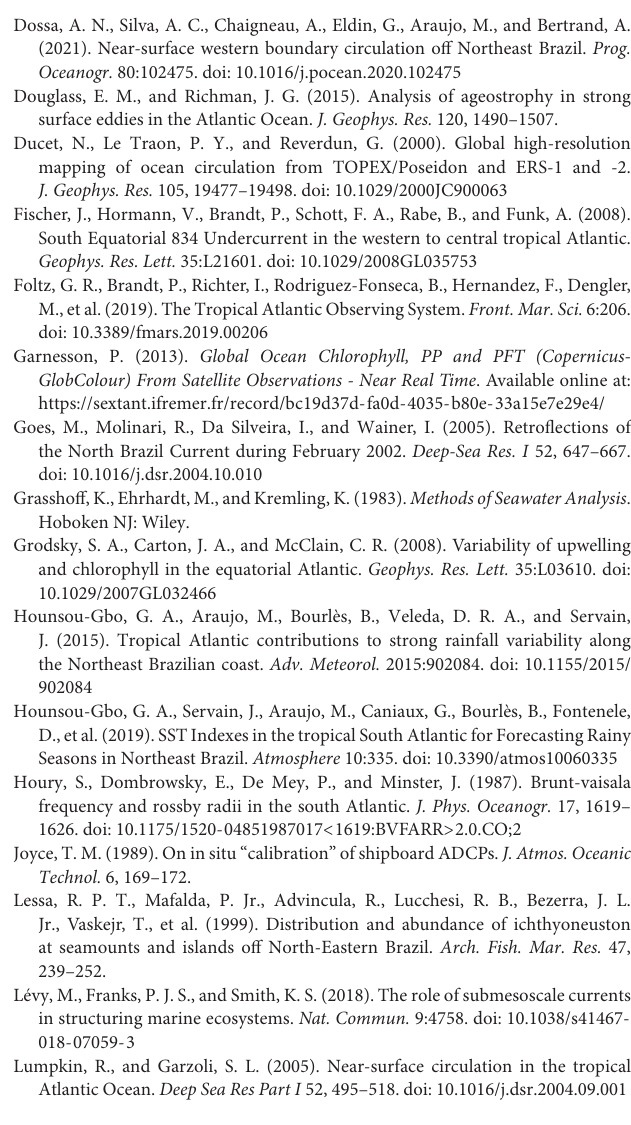
Supplementary Figure 1 | Sea surface temperature, Sea surface Chl-a concentration, Surface winds stress, and Sea surface height/surface geostrophic velocities, obtained from OSTIA product in the southwestern tropical Atlantic region (4 ◦ N-8 ◦ S, 39.25 ◦ W-27 ◦ W), involving Fernando de Noronha Archipelago and Rocas Atoll (rectangle), for the same time periods of ABRACOS cruises: spring 2015 (left side panels), and fall 2017 (right side panels). Supplementary Figure 2 | Vertical distributions of temperature, salinity, fluorescence, dissolved oxygen concentrations and Brunt-Väisälä frequency (N) near FN, during spring 2015 (left panels) and fall 2017 (right panels). Transects were obtained from CTDO stations 05, 04, 01, and 08 (spring 2015), and 45, 44, 50, and 51 (fall 2017), represented by black triangles. See Figure 2 for CTDO stations positions (pink